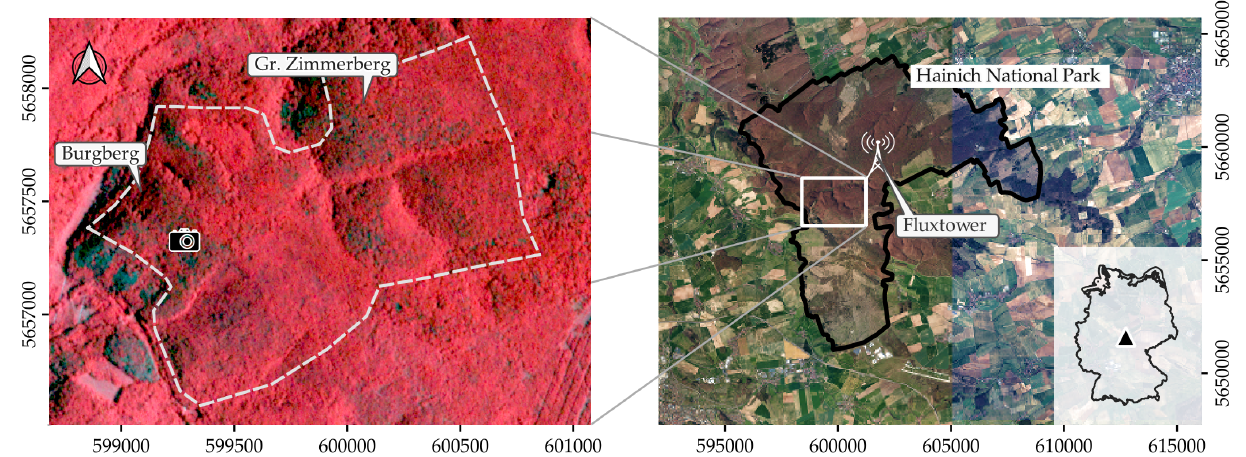
Figure 3. Left : Study area at Hainich National Park (HNP) comprising the two plateau hills Gr. Zimmerberg and Burgberg . PlanetScope color infrared orthomosaic (R: near-infrared, G: red, B: green) Y 2 (2020) [56]. Right : Overview of the study area in the HNP. Background true color orthomosaic from aerial flight campaigns